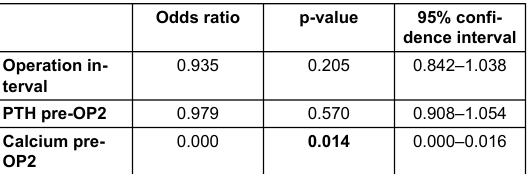
Table 2: logistic-regression analysis indicating preoperative hypocal- caemia as a risk factor for postoperative hypocalcaemia after second surgery (p <0.05). Time-interval between surgeries and preoperative PTH level could not be identified as risk factors for postoperative hypocalcaemia after second surgery (p >0.05).